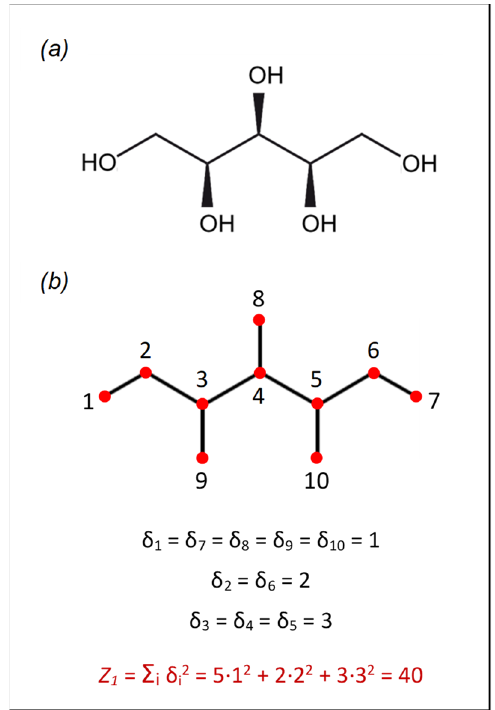
Figure 6. Calculation of the first Zagreb index ( Z 1 ) for xylitol: ( a ) chemical structure of xylitol; ( b ) hydrogen-depleted molecular graph. Graph vertices are numbered from 1 to 10. δ i is the vertex degree of vertex i .